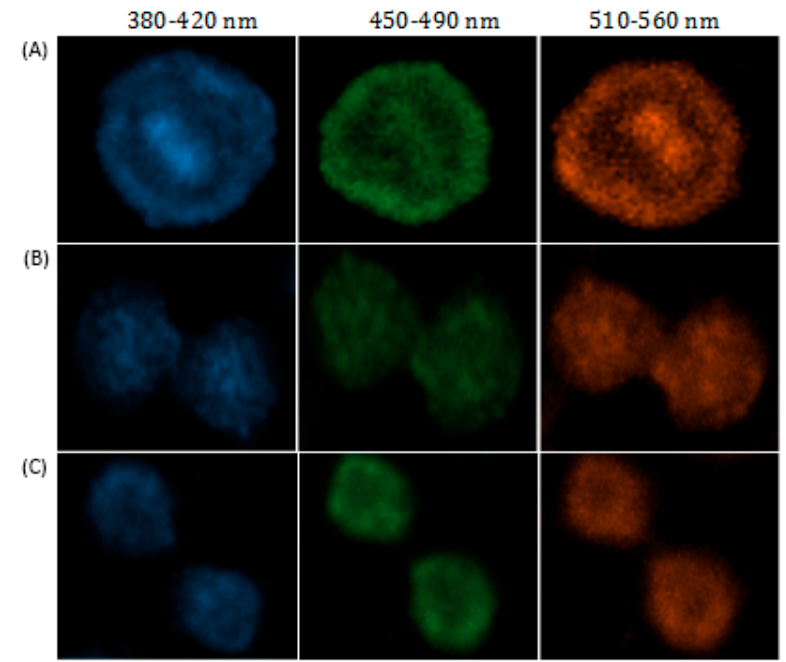
Figure 7. ( A – C ) Asynchronous cell imaging shows mitotic cells stained by N-CQDs visualizing chromosome aggregation through progression of mitosis’ prophase, metaphase and anaphase, respectively. The 1.6 mM N-CQDs were added to the cells and incubated for 24 h.